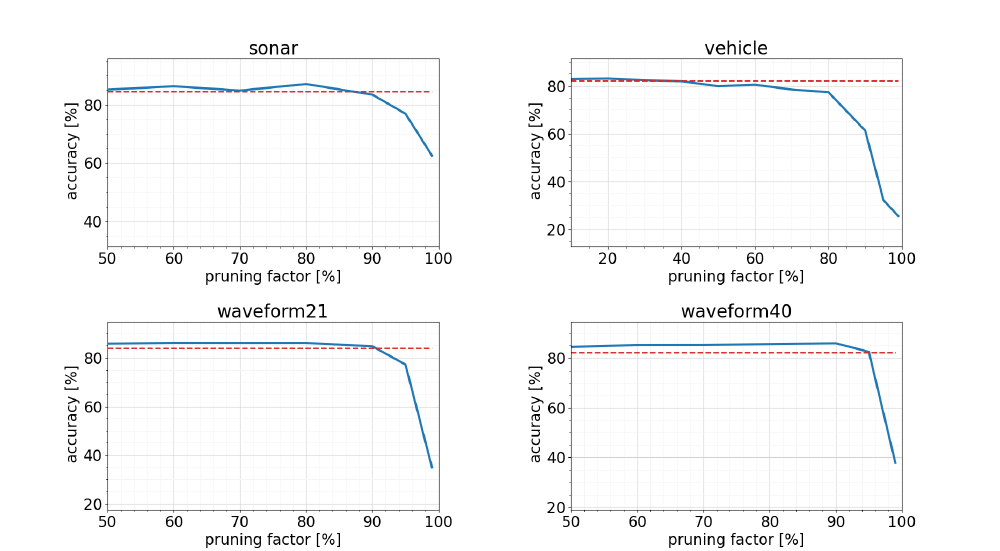
Figure 13. Results of pruning MLP ANN structure on sonar, vehicle, waveform21 and waveform40 datasets.